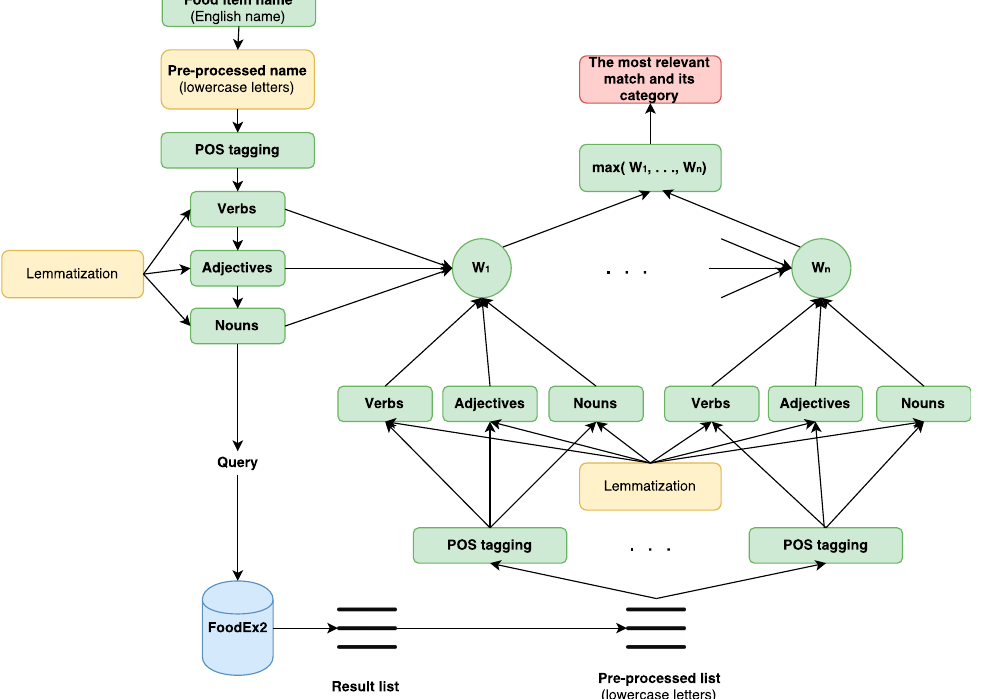
Figure 2. StandFood description part flowchart. For each food item that needs to be